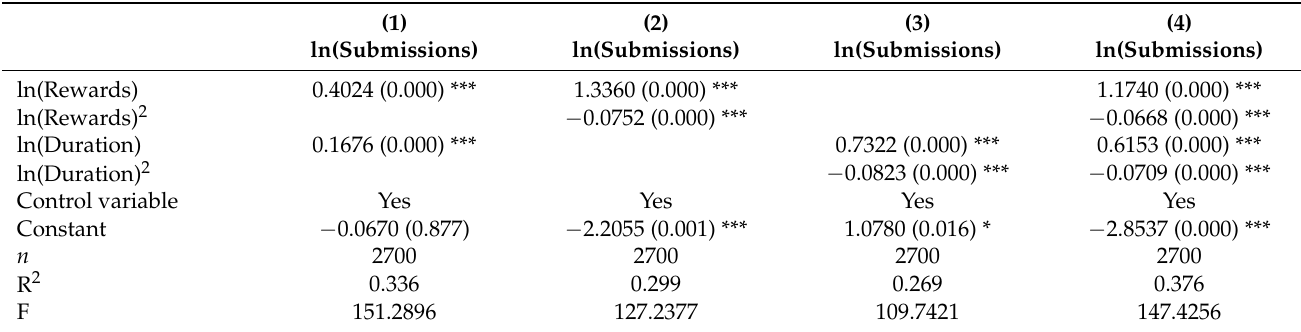
Table 5. Regression results of Equation (1).